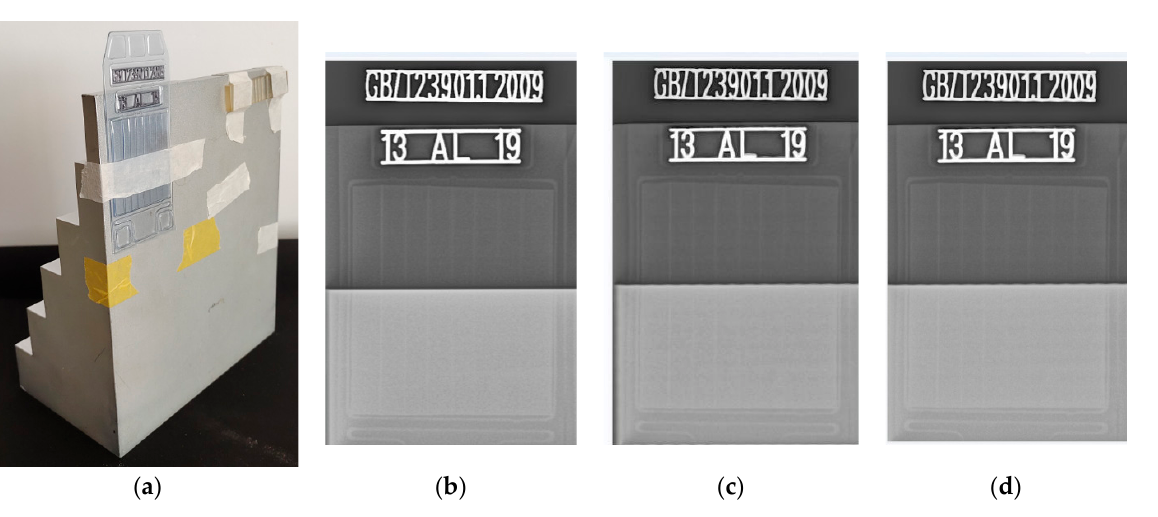
Figure 10 . Test results of the contrast sensitivity: (a) experimental device, (b) original image, (c) 2 × 2 Sub-Pixel Shift Image, (d) 4 × 4 Sub-Pixel Shift Image.